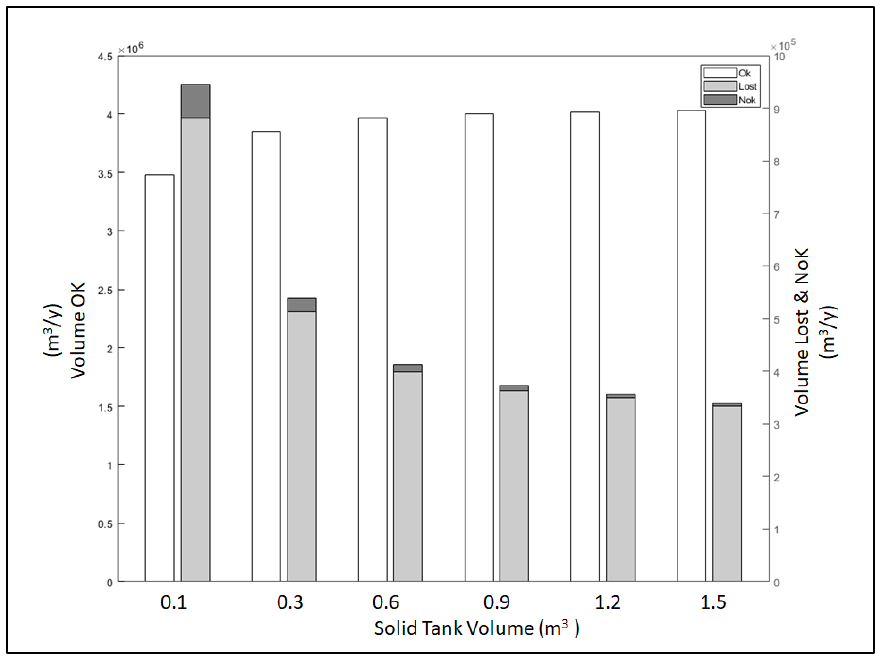
Figure 19. Volume of the mixture processed in a good way (OK), dumped (NOK), or not processed at all (Lost).